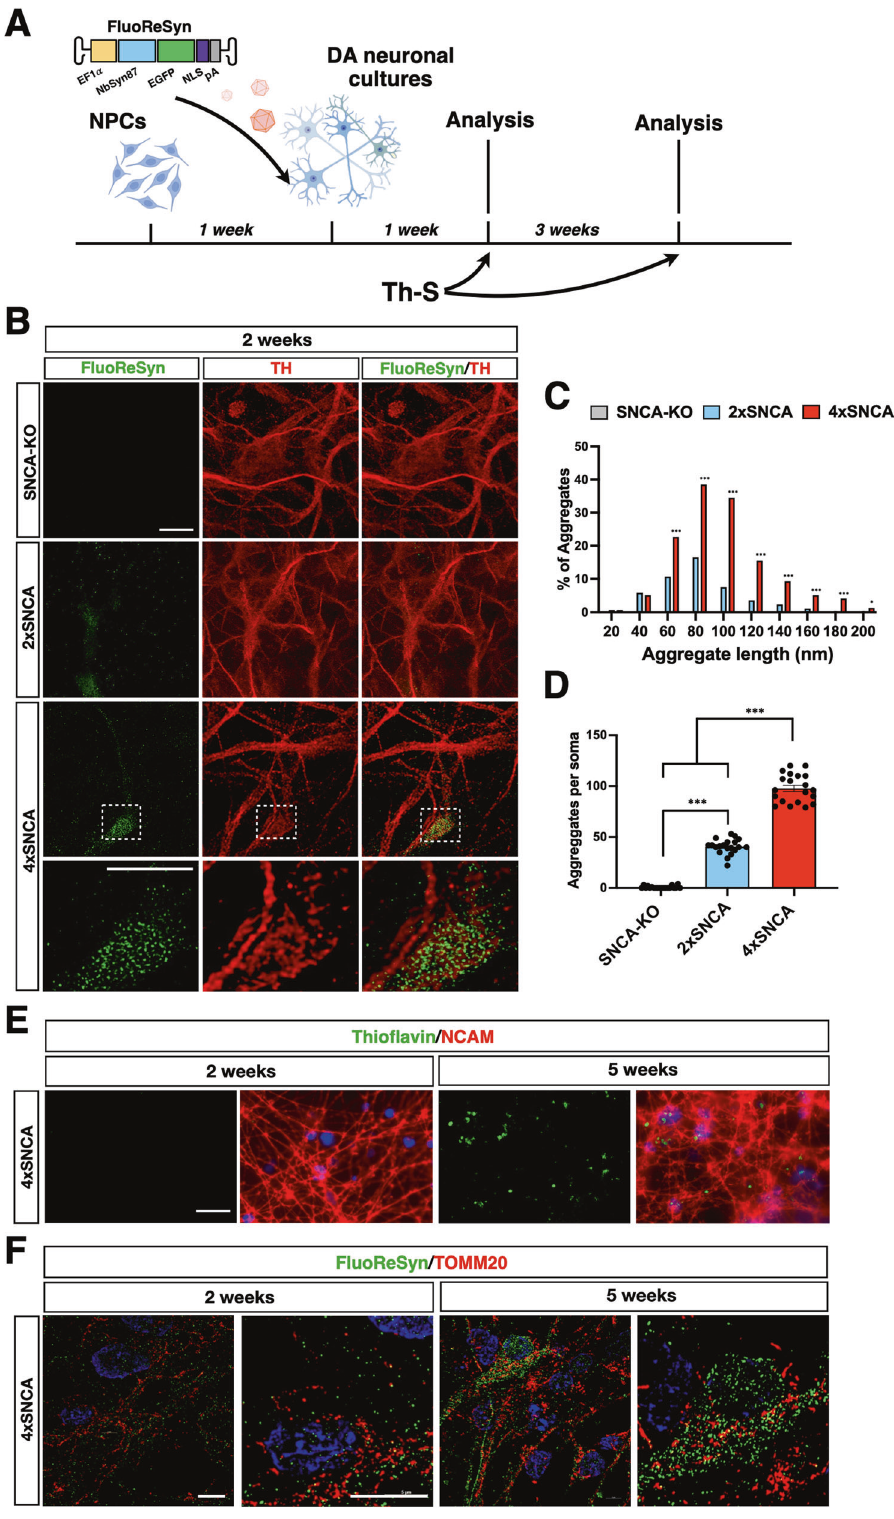
Fig. 2 FluoReSyn imaging enables the early detection of endogenous α Syn aggregates in DA neurons. A Schematic view of the protocol to infect DA neuronal cultures with AAV-FluoReSyn. B Immunostaining for FluoReSyn shows high-level α Syn assemblies in 4x SNCA compared to isogenic control 2x SNCA DA neurons. C , D Quanti fi cation of the number of α Syn aggregates ( C ) and their size ( D ) in 2x and 4x SNCA DA neurons. Dots indicate quanti fi cations in fi ve different fi elds for four independent experiments. E Representative images of Thio fl avin S signal in 4x SNCA DA neurons. F Images of super-resolved imaging show overlapping between α Syn puncta and mitochondrial structures in 2 and 4 weeks old 4x SNCA DA neurons. Values are mean ± SEM. * p < 0.05, ** p < 0.01, *** p < 0.001. Statistical analysis is performed using one-way ANOVA followed by Tukey post-test. Scale bars, 100